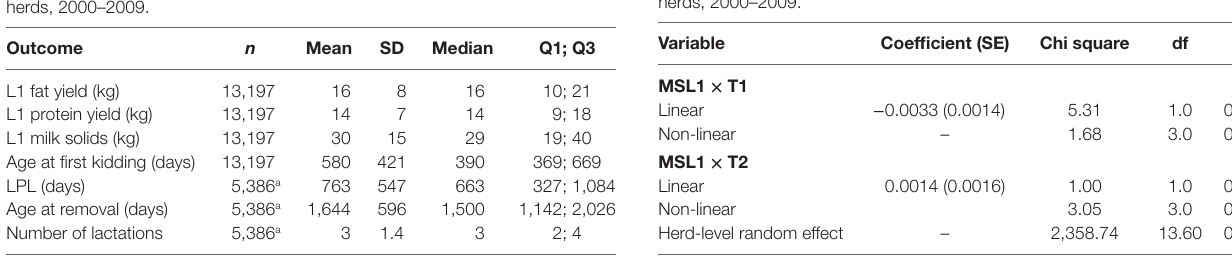
Descriptive statistics of first lactation production outcomes, age at first kidding, LPL, age at removal and total number of